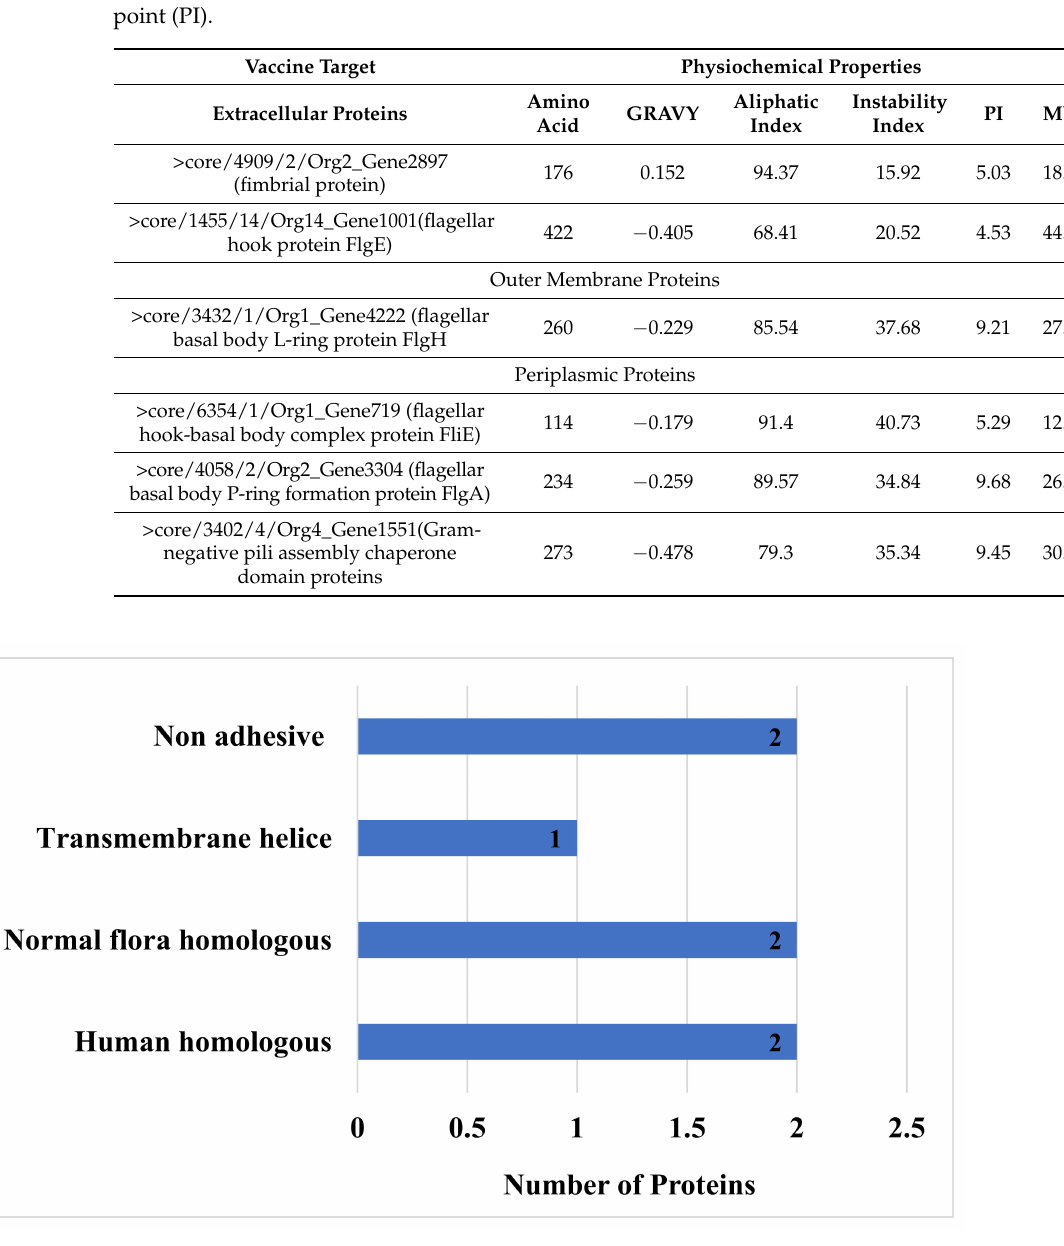
Figure 3. Number of non-adhesive normal flora and homologous proteins that have more than one transmembrane